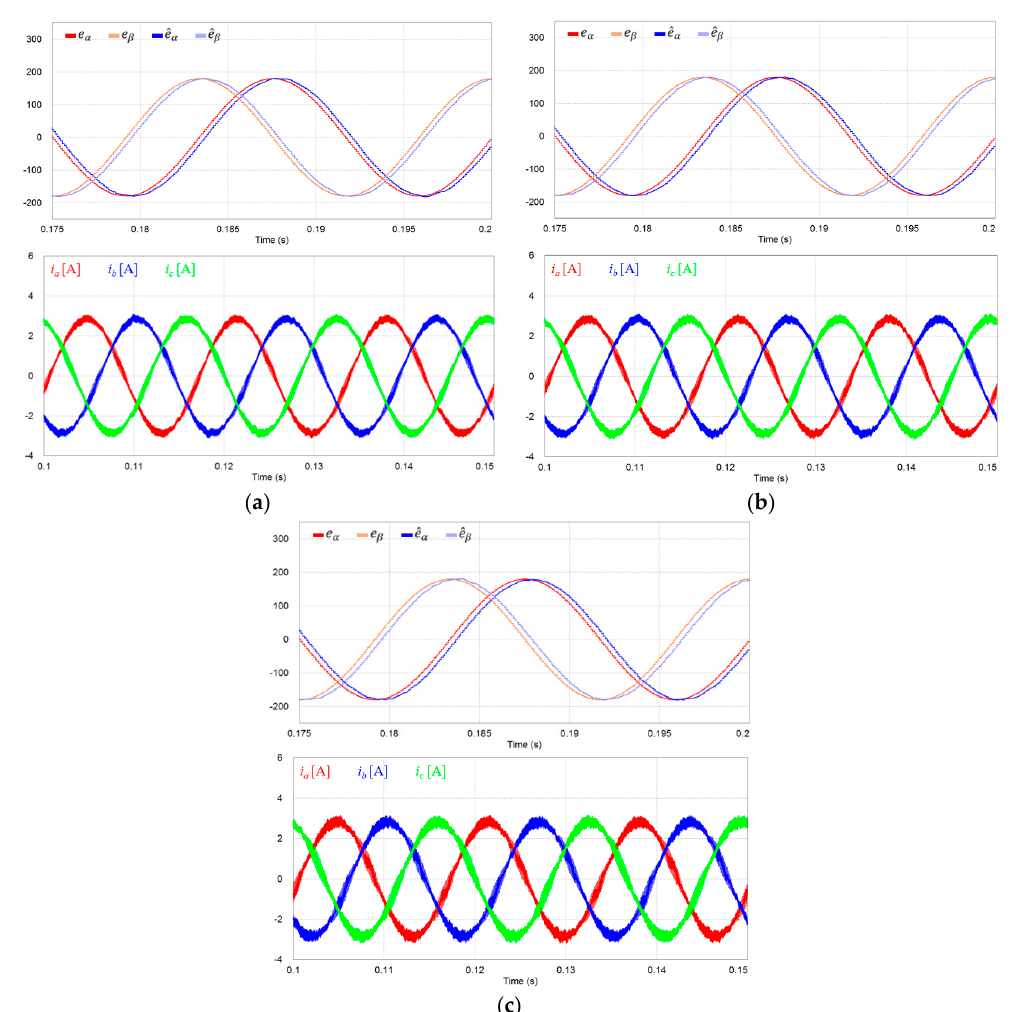
Figure 12. Estimation of grid voltages and inverter output currents under inductance variation. ( a ) +20% variation; ( b ) +10% variation; and ( c ) − 20%